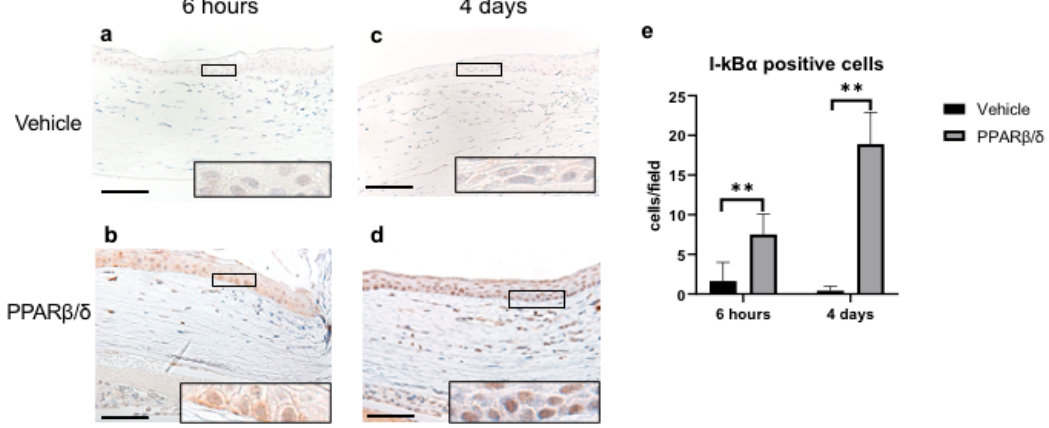
Figure 3. Immunostaining of NF- κ B and quantitative evaluation analyzed by cell counting on the corneal periphery in each group. ( a , b ) Representative sections at 6 h after the injury are shown. As compared to the PPAR β / δ group, the vehicle group exhibited strong staining in the nucleus of inflammatory cells (see boxed area). ( c , d ) Representative sections at day 4 after injury are shown. Higher magnification pictures of the boxed area are also shown. NF- κ B-positive inflammatory cells (black arrows) were observed in the corneal limbs. Bar, 50 μ m. The number of cells stained in the nucleus was significantly lower in the PPAR β / δ group versus the vehicle group at each of the time points ( e ). Data are presented as mean ± SD ( 𝑛 = 8) ** p < 0.01.